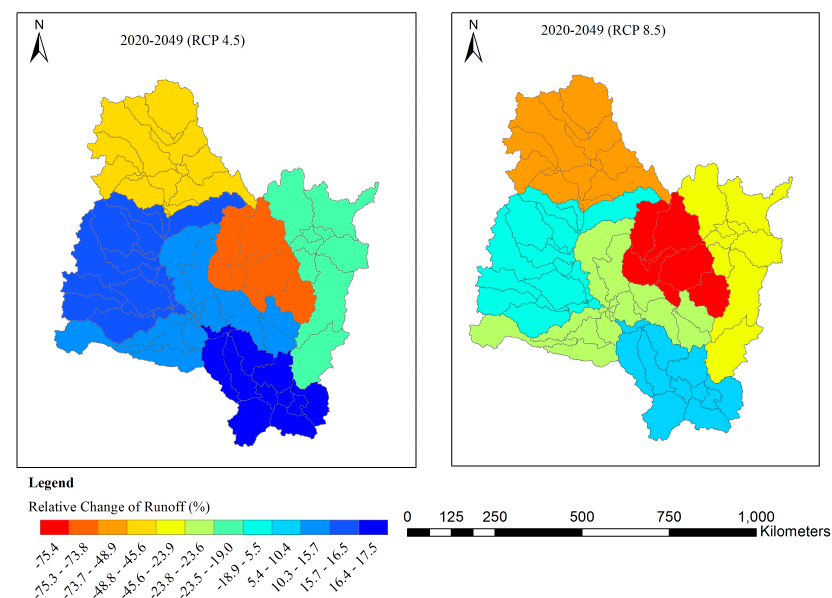
Figure 9. Spatial characteristics of relative changes of runoff in the Songhua River Basin for 2020–2049 under future climate scenarios (RCP 4.5 and RCP 8.5) when compared with runoff of 1980–2009. Spatial variations of runoff within the six units are not considered.